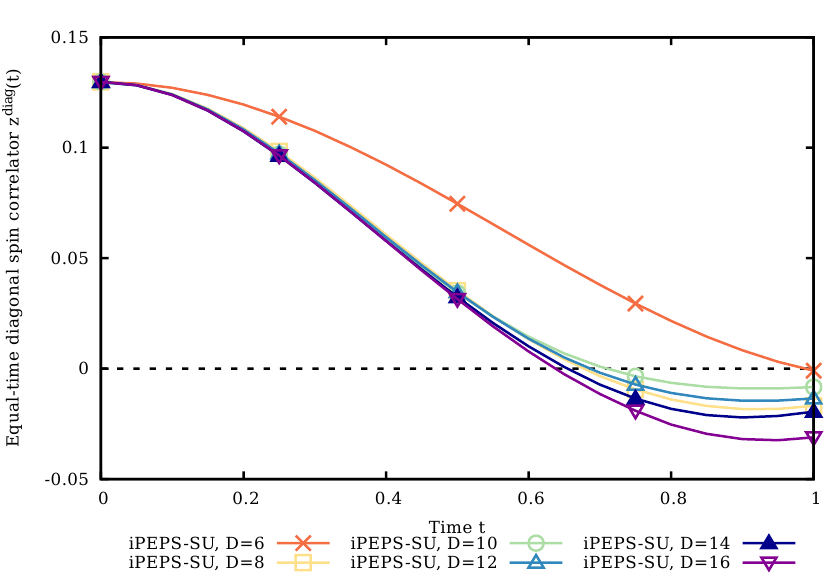
Figure 4: Equal-time diagonal spin correlator z diag ( t ) when a hole is present in the lower right side of the two spins calculated using iPEPS with the simple update. The expected zero crossing is observed when increasing the iPEPS bond dimension around time t ≈ 0.6. Data is evaluated every δ t = 0.05, with symbols shown only for